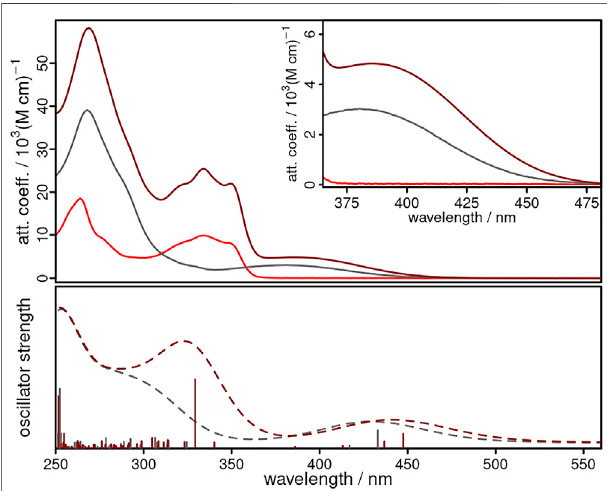
FIGURE 3 | Experimental (top, solid lines) and calculated (bottom, dashed lines, B3LYP-D3(BJ)/def2-tzvp) UV/vis absorption spectra of NIphen (light red), CuNIphen (dark red) and Cuphen (grey) in acetonitrile. The inset shows an enlarged region of the absorption from 365 to 480